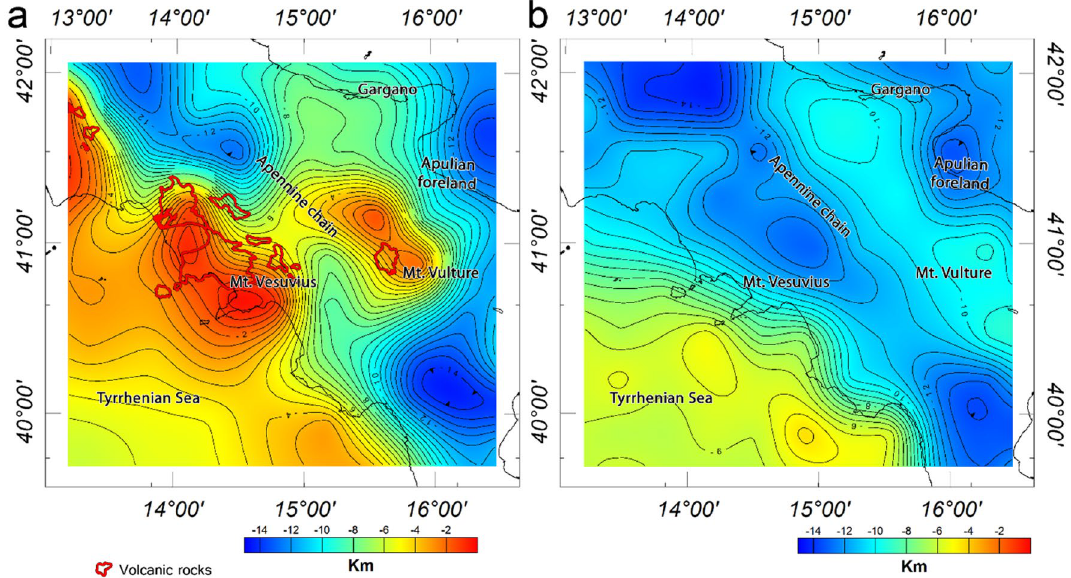
Figure 6. Depth to the top of magnetic sources estimated from magnetic anomalies ( a ) and depth to the top of crystalline basement estimated from the vertical gradient of gravity data ( b ). The maps were generated using the Oasis Montaj Geosoft software (v.9.9.1.34 https:// www. seequ ent. com/ produ cts- solut ions/ geoso ft- oasis-